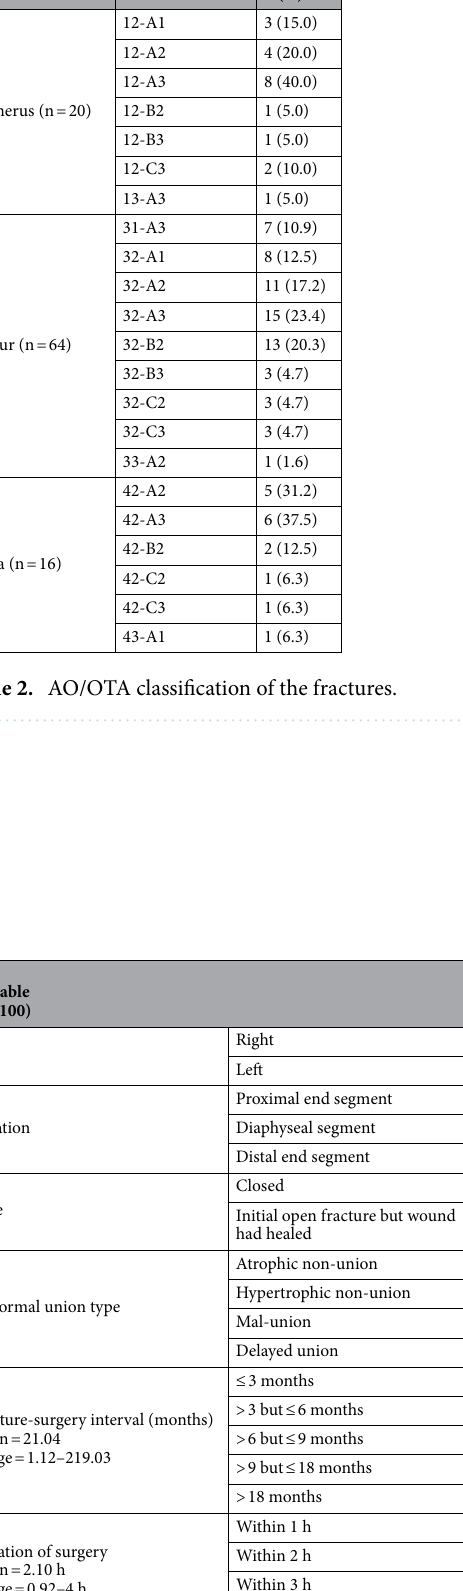
Fracture-surgery interval (months) Mean = 21.04 Range =